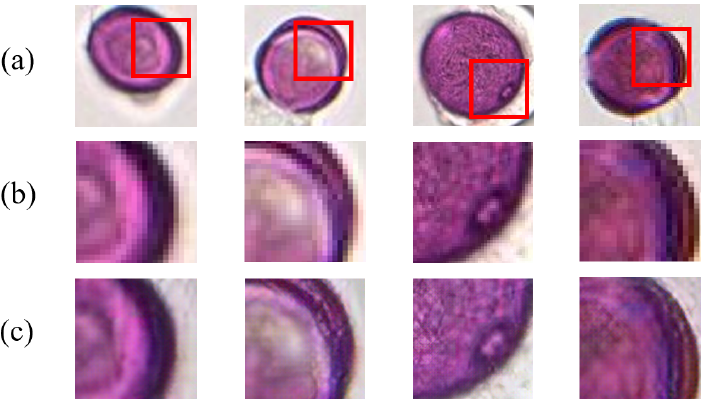
Figure 6. Several low-resolution images and their deblurred counterparts: ( a ) the original images; ( b ) the deblurred images using bilinear interpolation; ( c ) the deblurred images using our deblurring